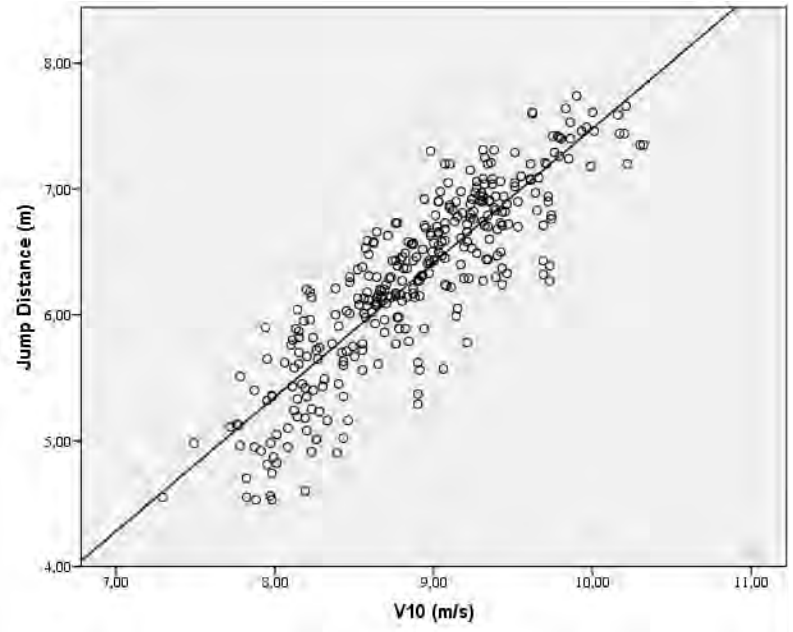
Figure 4. The relationship between the approach run-up velocity which is V10 (11-1 m) and official jump distance (r=0.87, p<0.05; r 2 =0.76) Table 2. Significant test results of regression